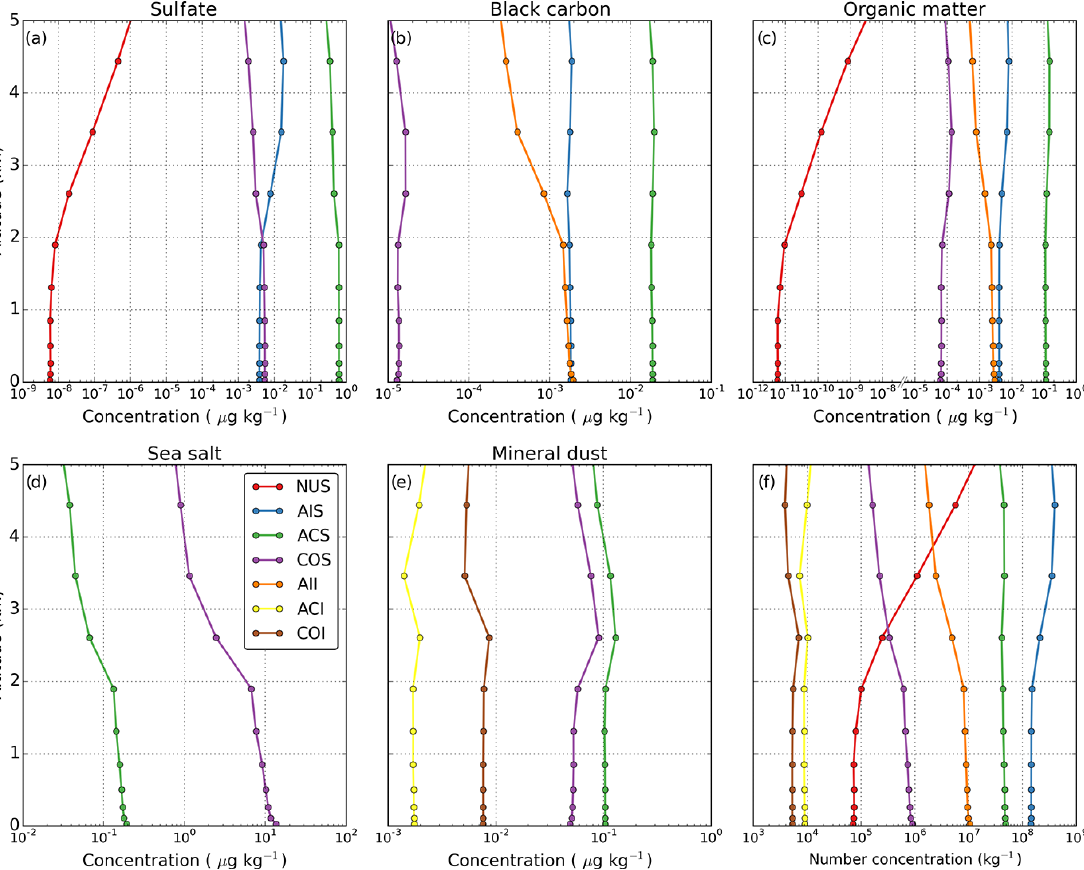
Figure 2. Initial vertical profiles of aerosol mass concentration (µgkg − 1 ) of (a) sulfate, (b) black carbon, (c) particulate organic matter, (d) sea salt, (e) mineral dust, and (f) number concentration (kg − 1 ) extracted from the TM5 model (Bergman et al., 2019). Aerosol modes are specified by different colours, which are consistent between panels. Circles correspond to the TM5 model levels. Note the break in the horizontal axis in panel (c)